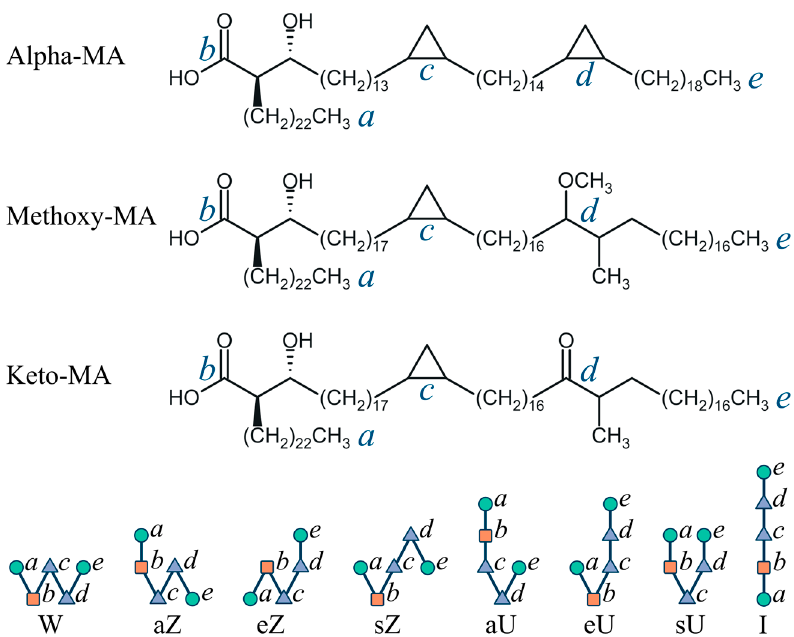
Figure 1. Mycolic acid types in Mtb and designations of their possible conformations.